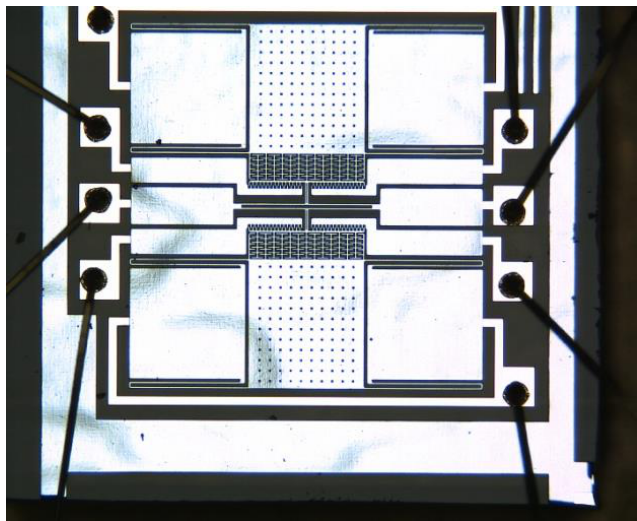
Figure 10. Fabricated microstructure (single-stage beam).